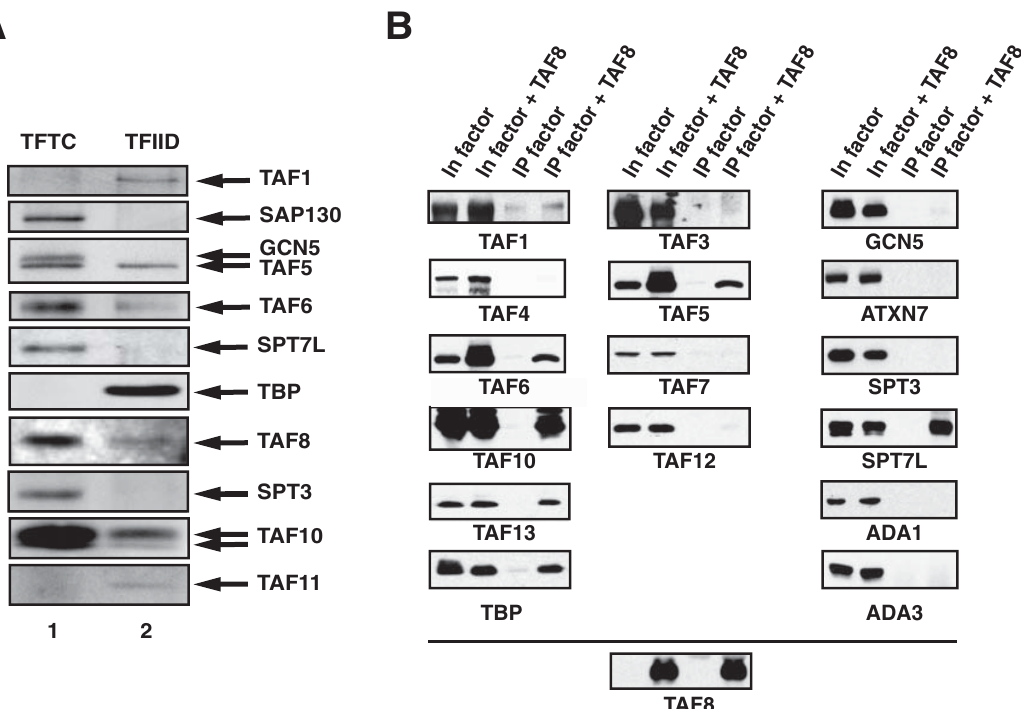
Figure 1. TAF8 is present in both TFIID and TFTC preparations while SPT7L is associated with TFTC. (A) TFIID and TFTC complexes were purified [7], separated by SDS-PAGE and the presence of different subunits were analysed by Western blot using the indicated antibodies. (B) TAFs, TBP (left panels) and certain TFTC subunits (right panels) were individually expressed (In factor) or coexpressed with TAF8 (In factor + TAF8) in Sf9 cells as indicated and WCEs were made. TAF8-containing complexes were immunopurified (IPed) with an anti-TAF8 mAb (2TAU 2B8). Protein expression in the input fractions and TAF8-bound proteins were analysed by western blot with the indicated antibodies. In each experiment, the expression and the IP efficiency of TAF8 was the same as shown in a single representative experiment (lower panel).